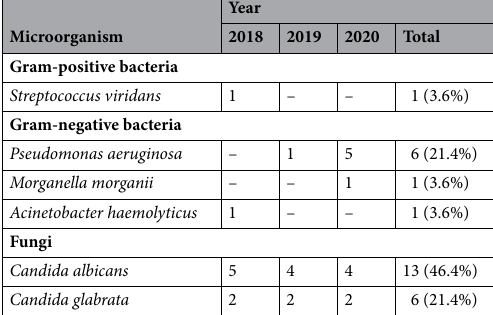
Table 1. Microorganisms cultured from the catheter tip (n = 28).